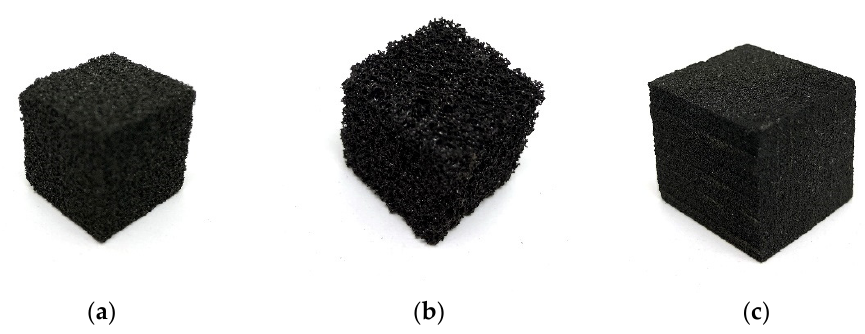
Figure 3. Photographs of ( a ) SDS 4 foam; ( b ) SDS 6 foam and ( c ) TWEEN 10 foam.